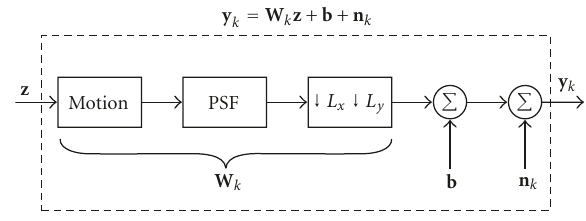
Figure 1: Observation model for simultaneous image superresolu- tion and nonuniformity